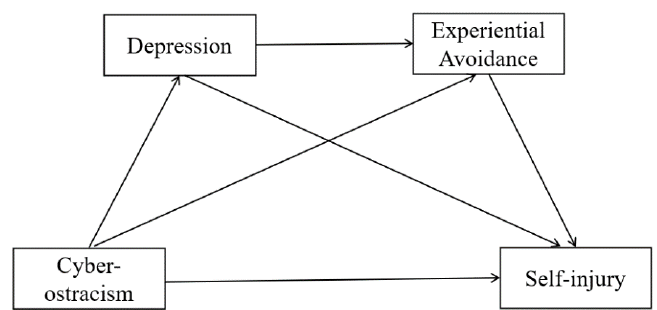
Figure 1. The proposed